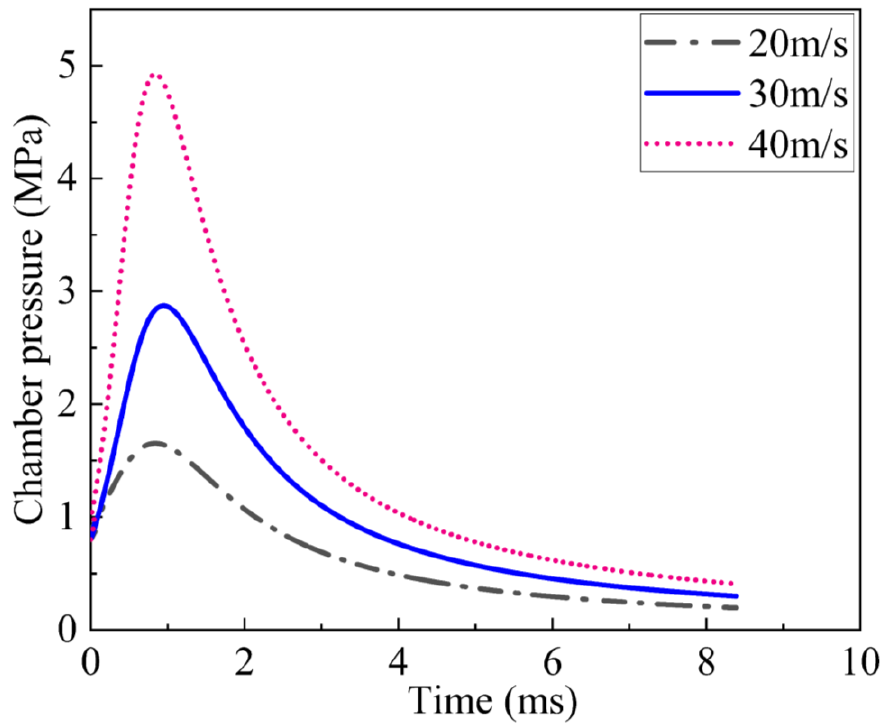
Figure 20. Chamber pressure with different launch speed